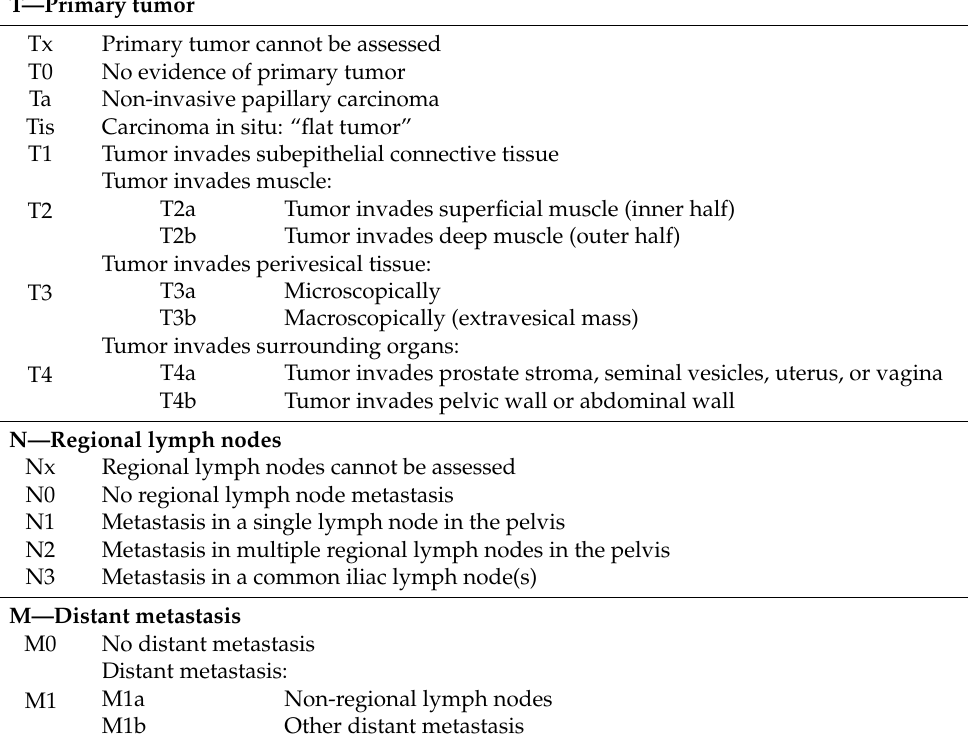
Table 1. TNM (tumor–node–metastasis) classification of bladder